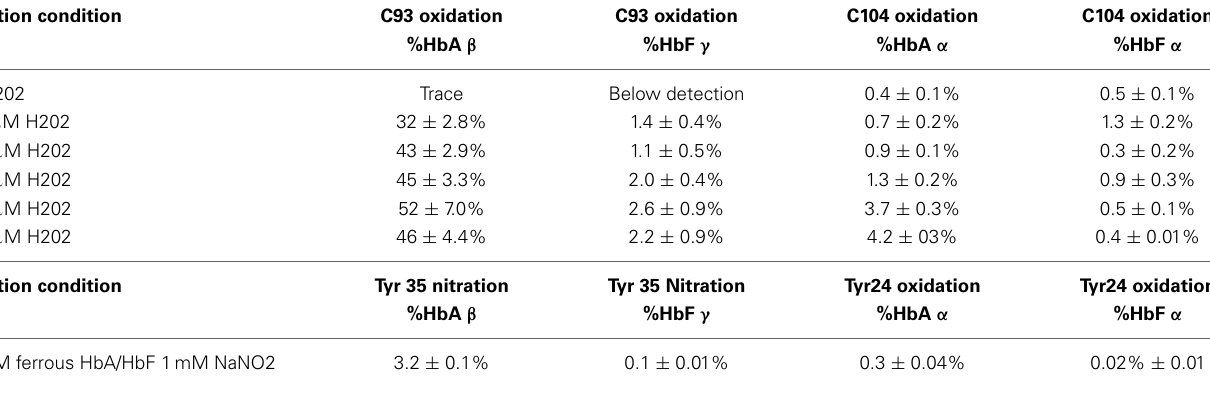
Table 2 | Oxidative ratios for C93 trioxidation of 10 μ M ferric HbA and HbF in the presence of H 2 O 2 as well as nitration of 40 μ M ferrous HbA and HbF in the presence of sodium